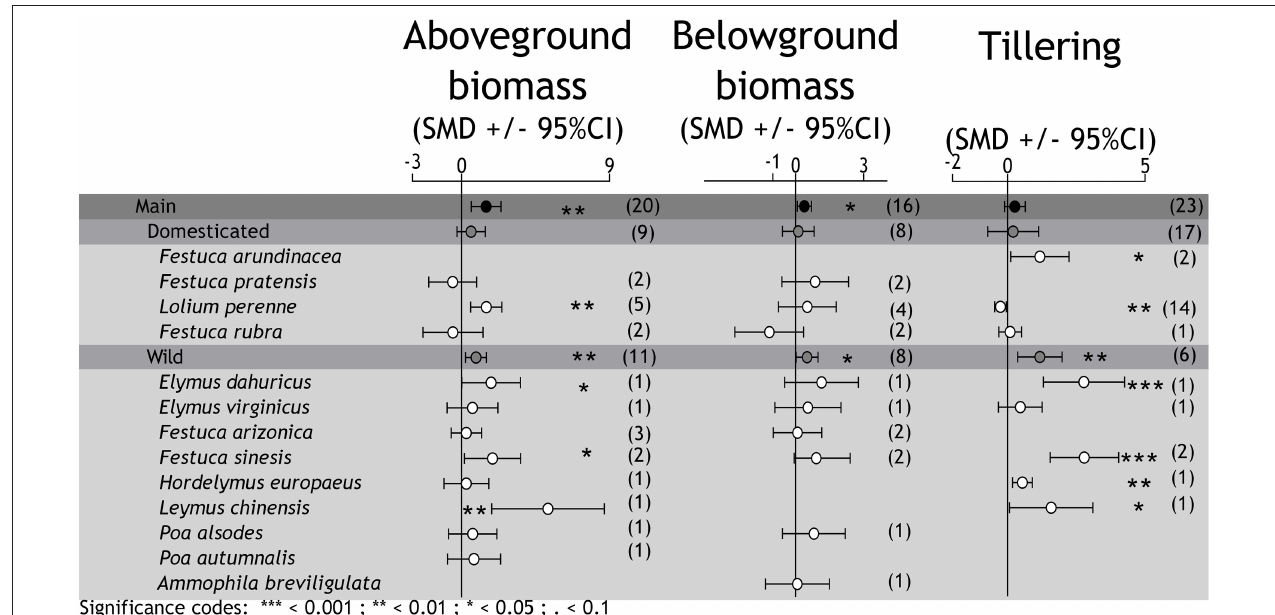
FIGURE 1 | The effects of Epichloë fungal endophytes on grass species performance (aboveground biomass, belowground biomass, and the number of tillers) under drought conditions. Mean effect sizes (SMD, standardized mean difference) and confidence intervals (95%CI) for the comparisons between E + and E– plants. The symbiotic associations are grouped in domesticated and wild grass species. The number of studies is indicated on the right to each value between parentheses. replicated only in wild grasses (aboveground biomass wild species